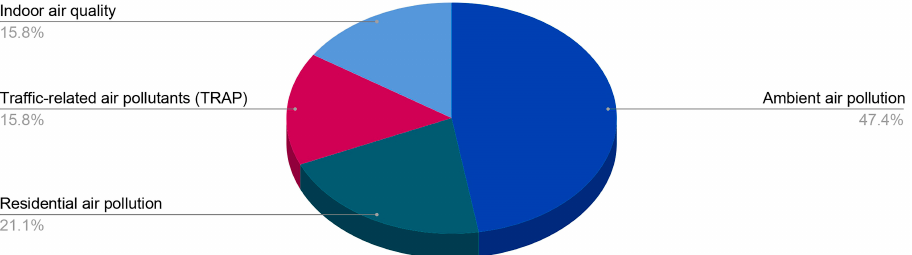
Figure 4. Categories of Air Pollution in the Literature.